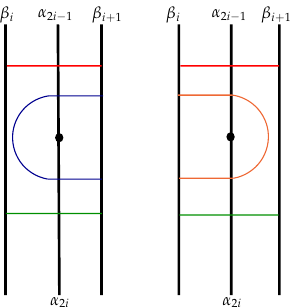
Figure 3. Connected components of L